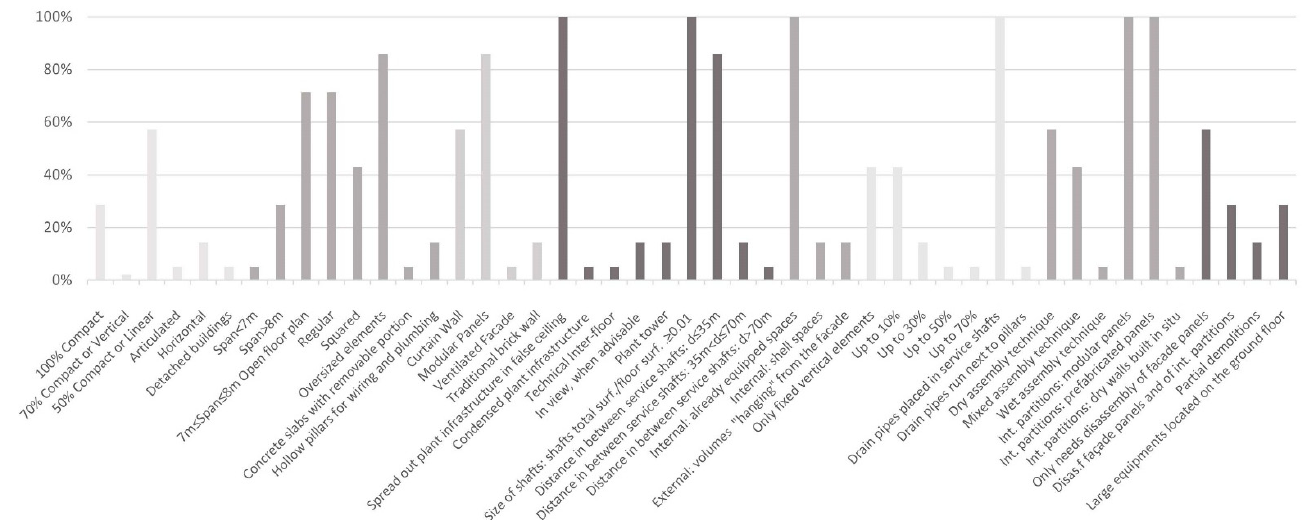
Figure 3. Histogram with percentage of evaluation parameters used. The horizontal x-axis lists the parameters included in the evaluation tool while on the vertical y-axes the fulfillment of each parameter based on the case studies analyzed is seen. The figure shows that some parameters are very common while others are rarer to be found in the selected case studies.